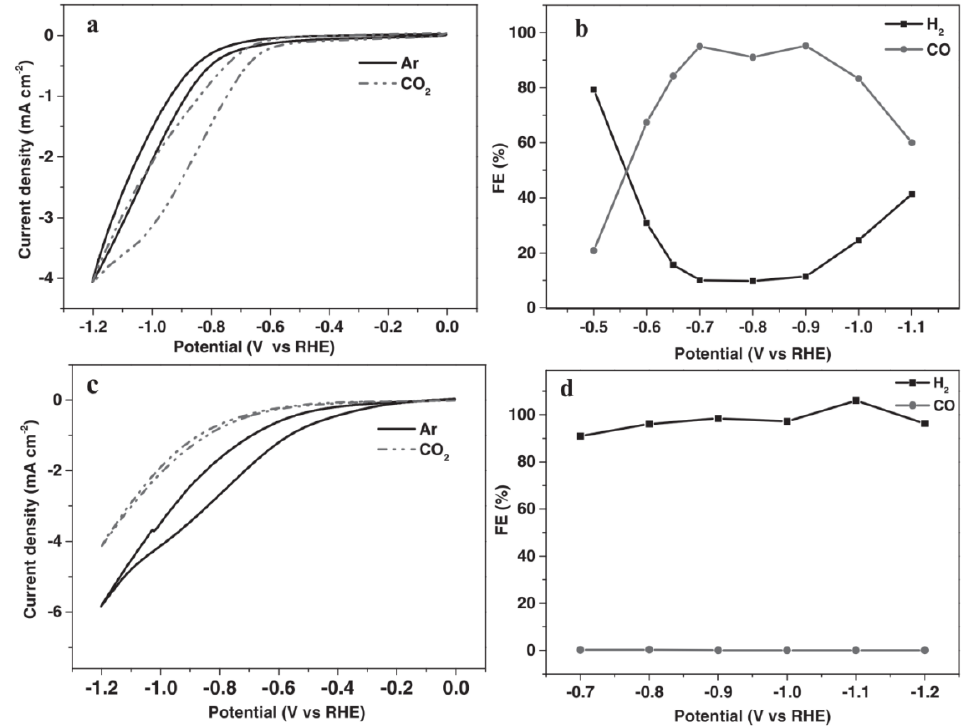
Figure 4. ( a ) Cyclic voltammograms of nickel–nitrogen comodified graphene (Ni–N–Gr) catalyst and ( c ) Ni foil in CO 2 -saturated 0.1 M KHCO 3 and Ar-saturated 0.1 M KH 2 PO 4 /K 2 HPO 4 (pH = 6.8) at 10 mV s − 1 . FEs for the reduction products by ( b ) Ni–N–Gr catalyst and ( d ) Ni foil. Reprinted from [81], Copyright (2016), with permission from Wiley.